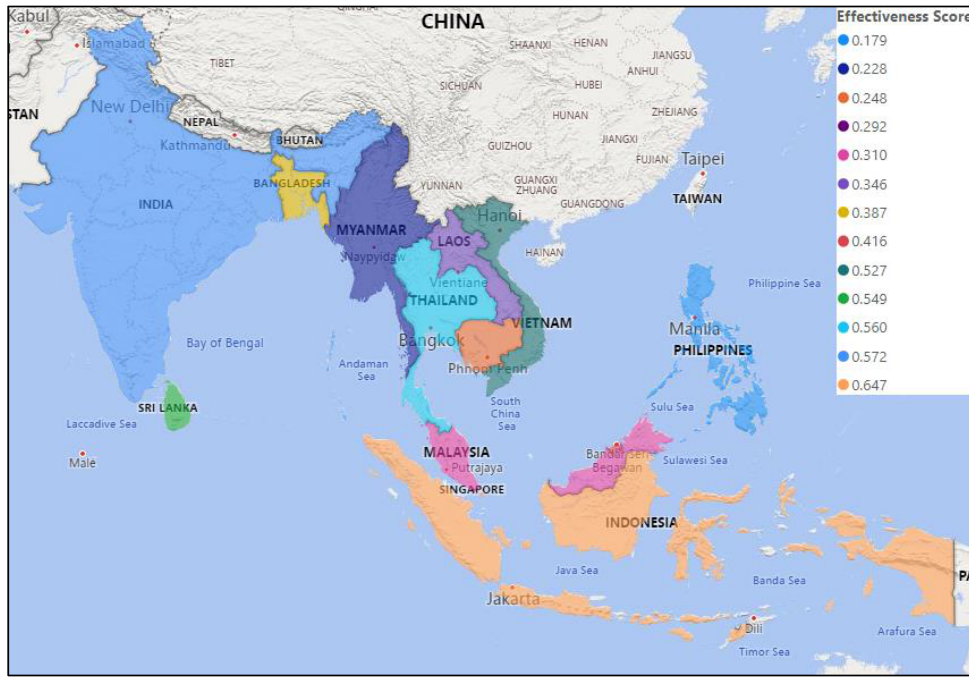
Figure 5. SfRDMA effectiveness map.